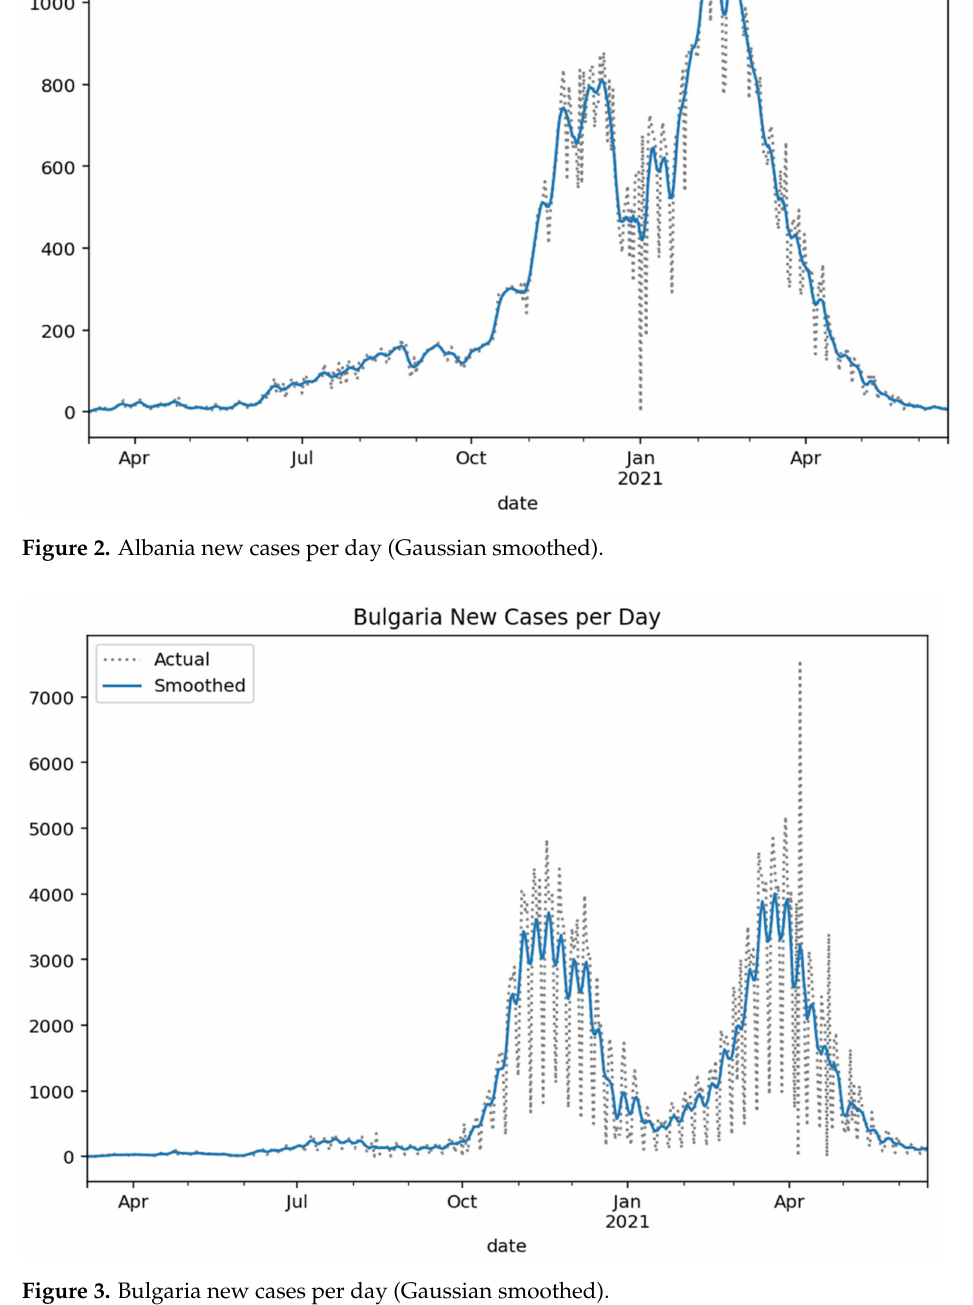
Figure 3. Bulgaria new cases per day (Gaussian